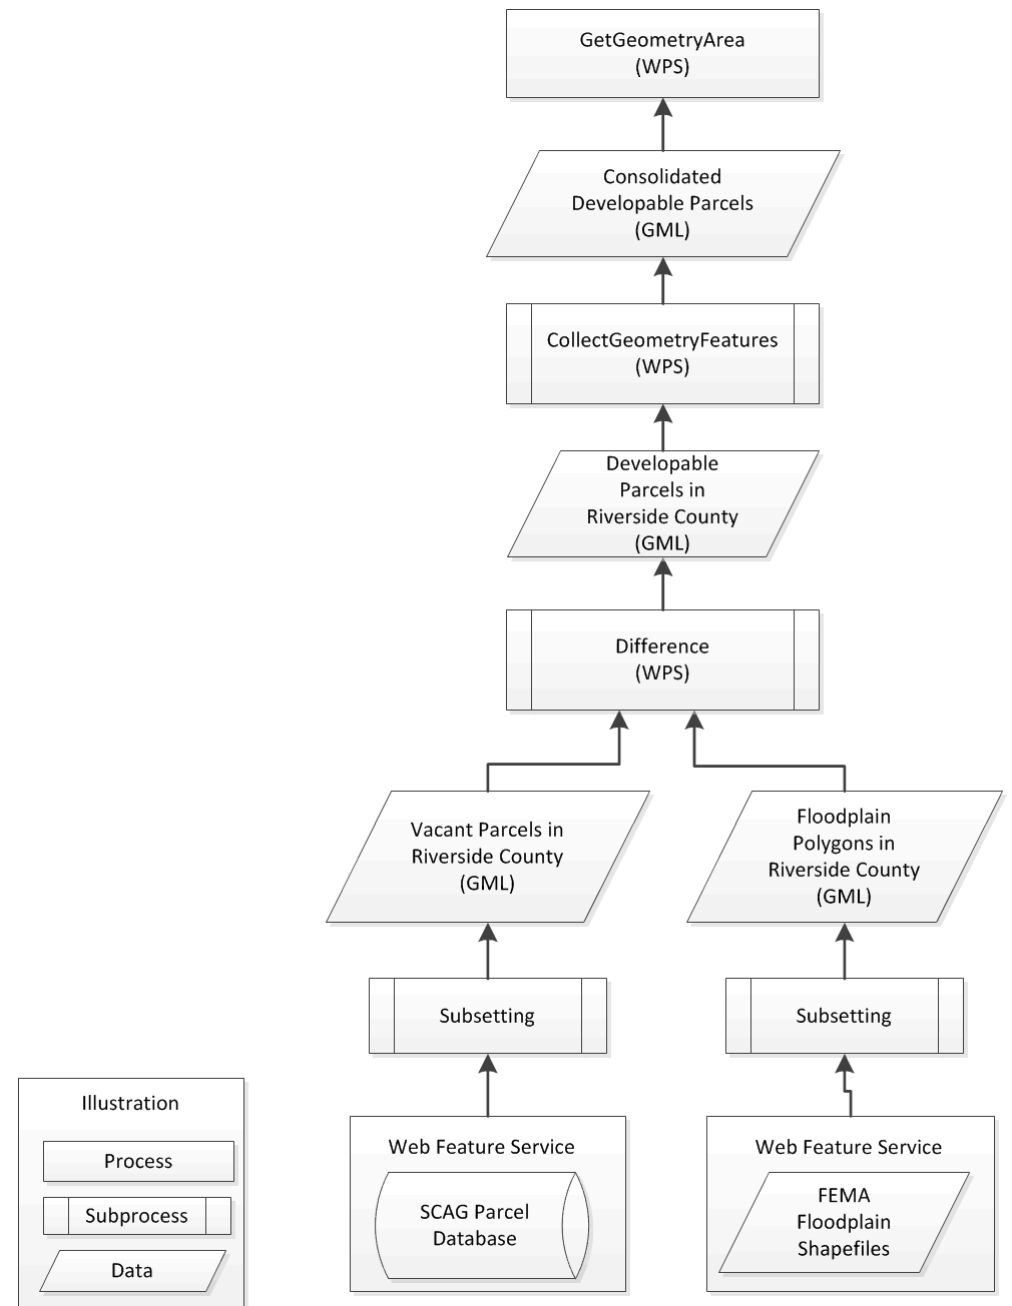
Figure 4. Workflow chart of chained